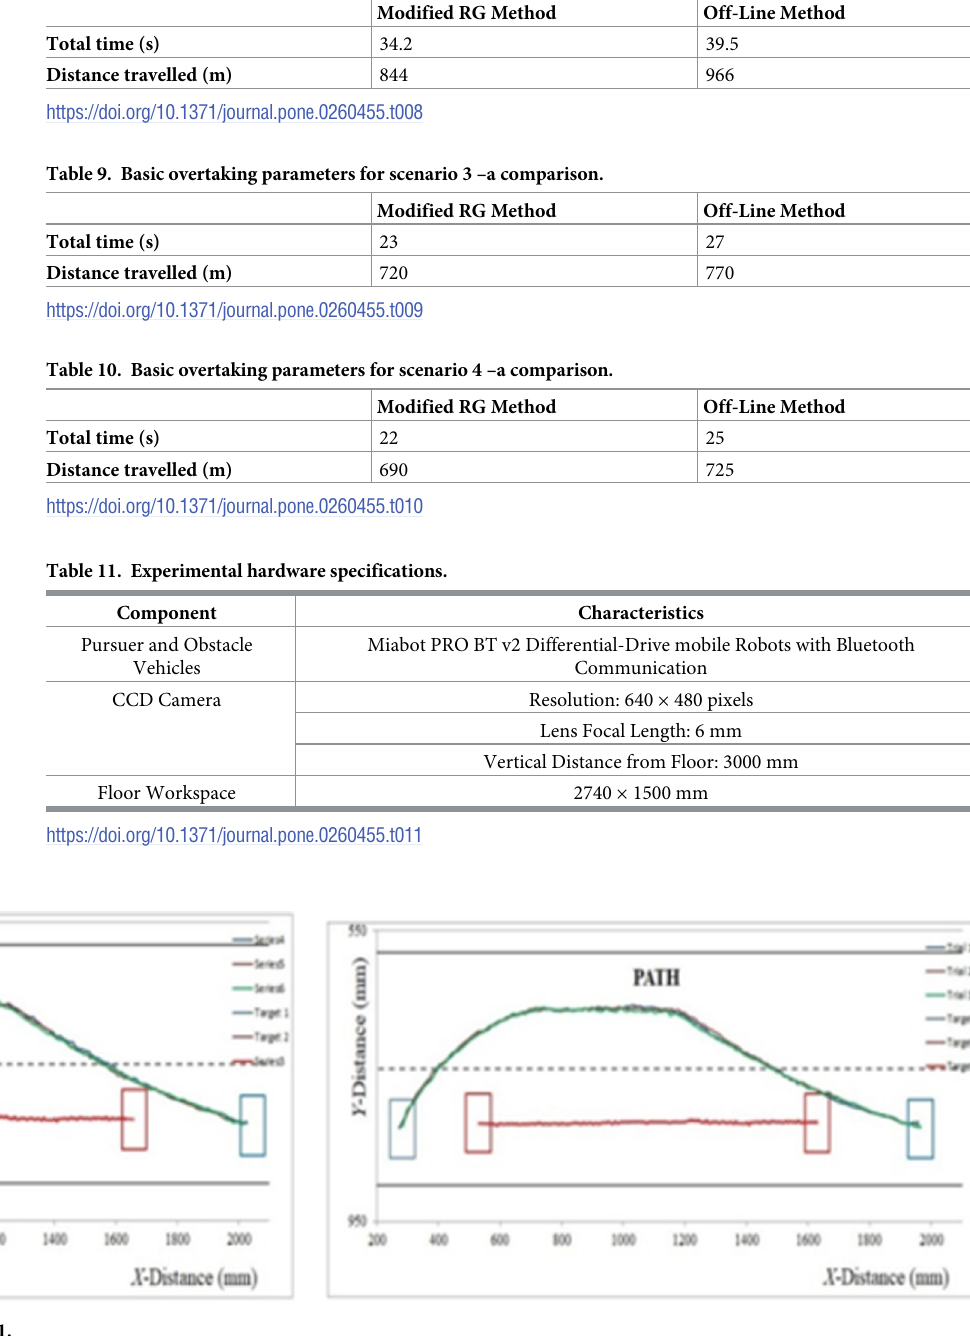
Fig 15. Marker target position for situation